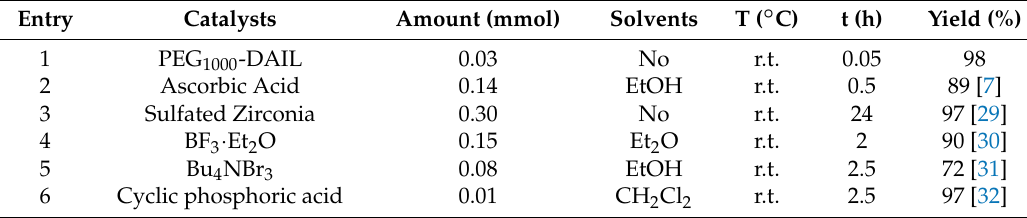
Table 3. Comparison of the condensation of benzaldehyde with indole with other